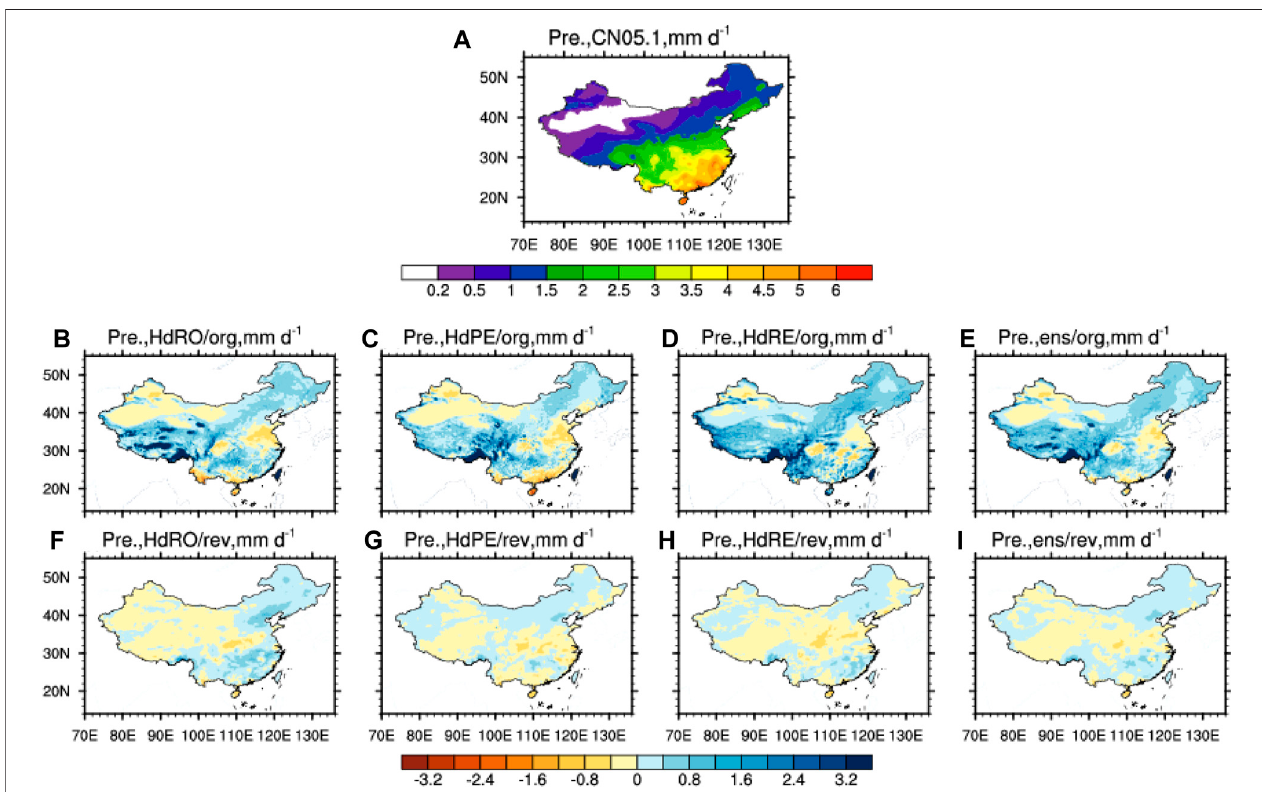
FIGURE1| Spatialdistributionsoftheobservationalannualprecipitation (A) andbiasesbetweenobservationsandsimulationsfromRCMsbeforecorrection (B – E) and after correction (F – I) .